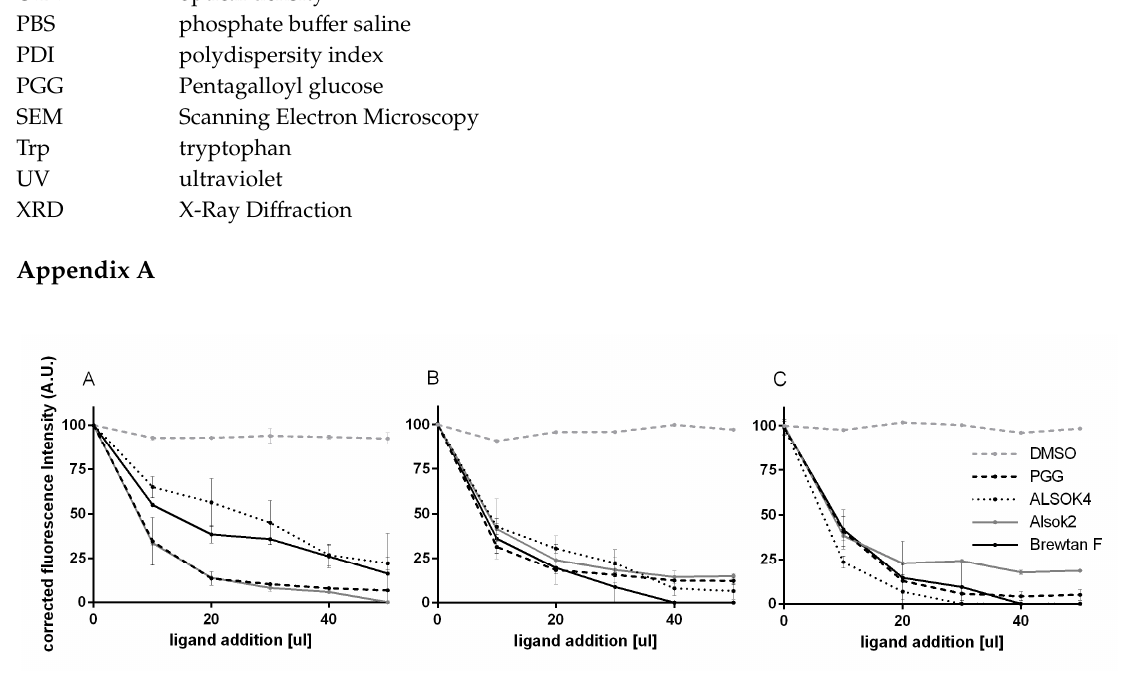
Figure A1. Relative fluorescence intensity of ( A ) ALP in water, ( B ) ALP + CaCl 2 in water, and ( C ) ALP + CaCl 2 + GG in water with increasing concentrations of gallotannins dissolved in DMSO after correction for inner-filtering effects. In all cases, n = 3.